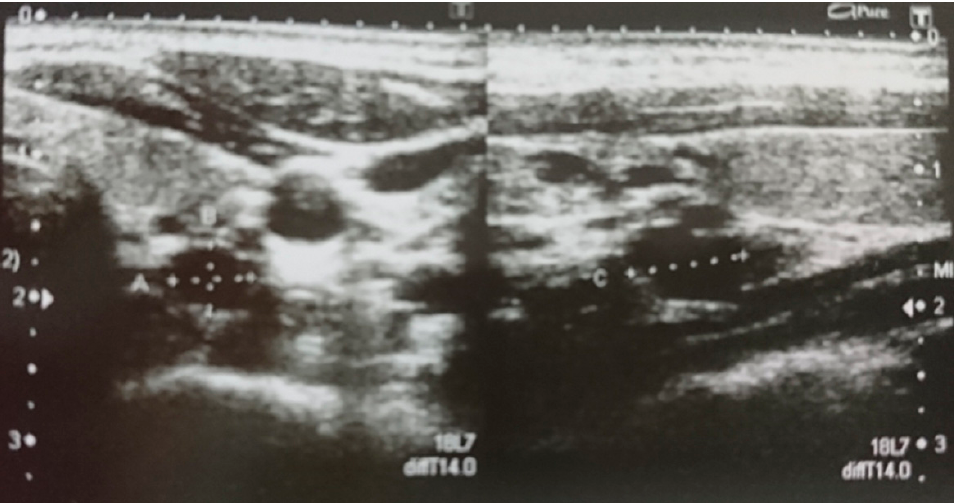
Figure 1. Sonographic image of left-inferior parathyroid adenoma before the 1 st surgery.